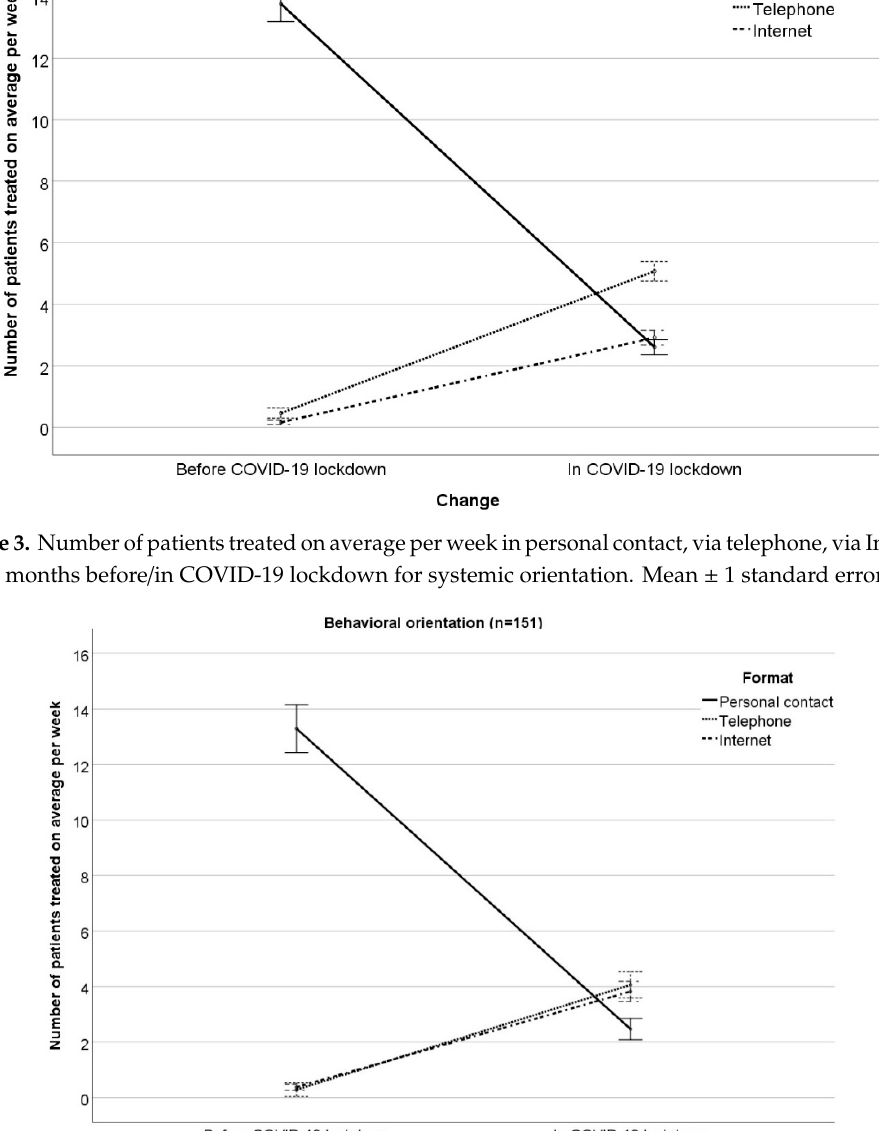
Figure 4. Number of patients treated on average per week in personal contact, via telephone, via Internet in the months before/in COVID-19 outbreak for behavioral orientation. Mean ± 1 standard error.